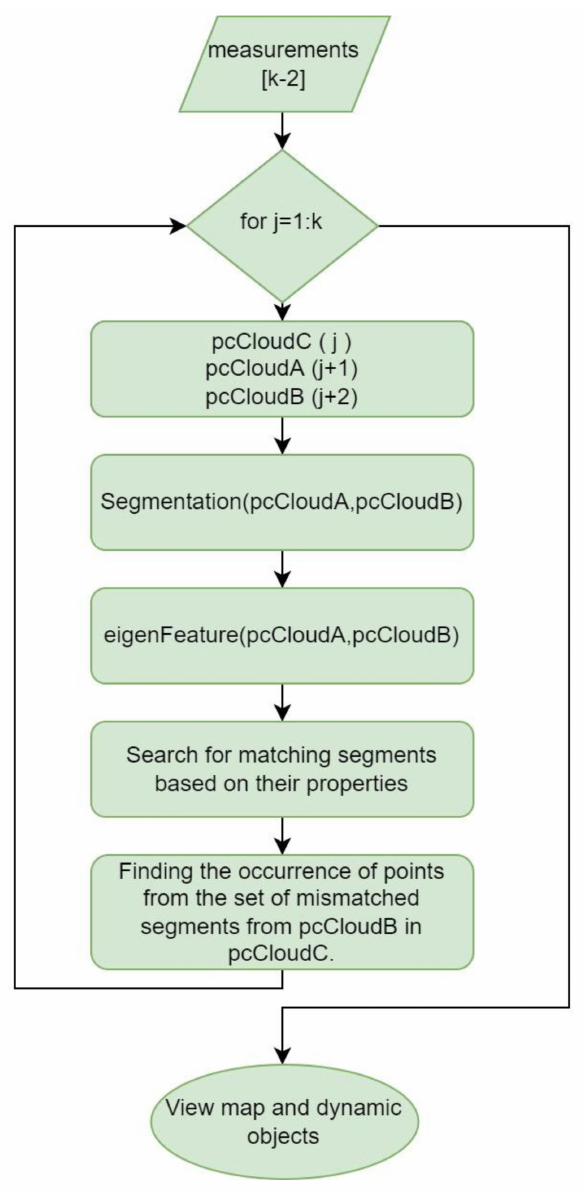
Figure 6. Flowchart for Algorithm